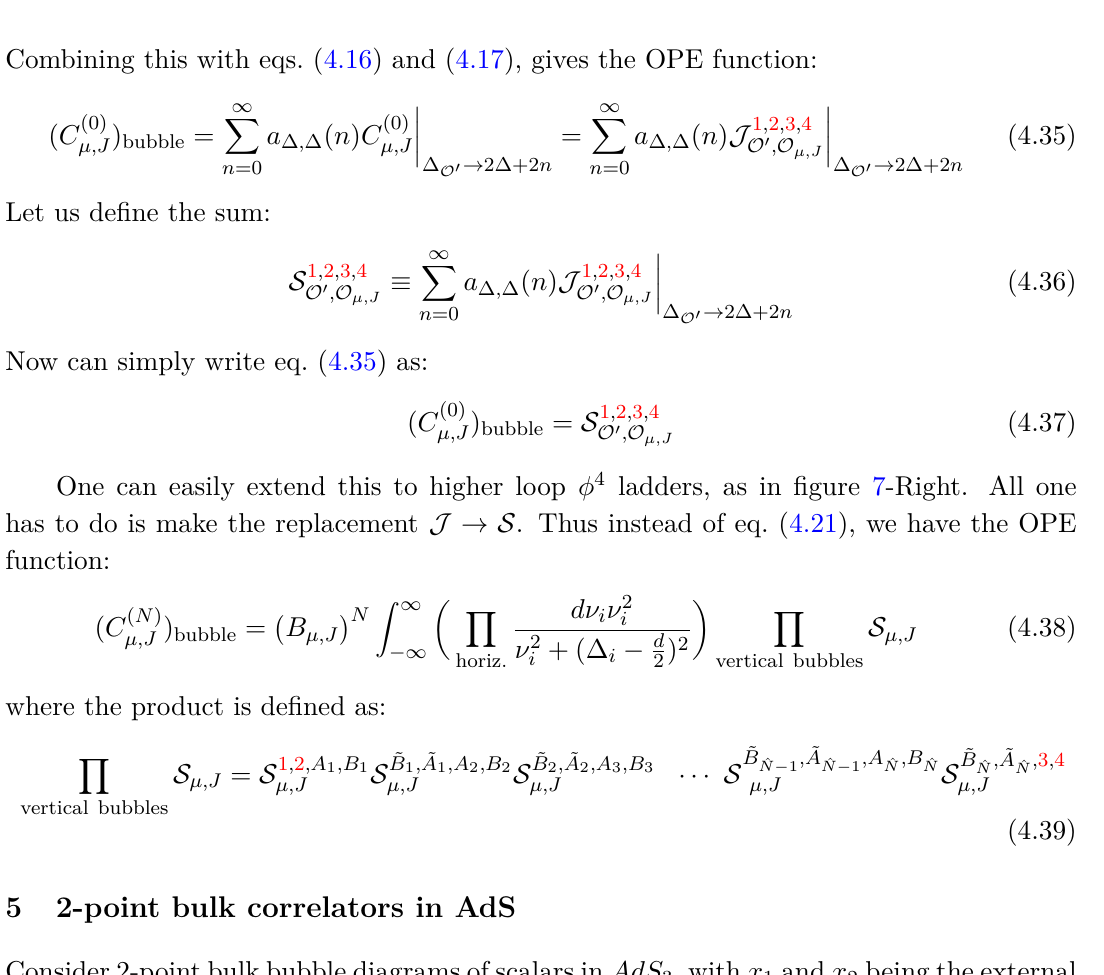
Figure 8 . The type of bubble diagrams which we consider in section 5. Left: φ 4 theory: the 2- point bulk-to-bulk correlator consisting of a sequence of M -bubbles. Right: φ 3 theory: the 2-point bulk-to-bulk correlator consisting of a sequence of M